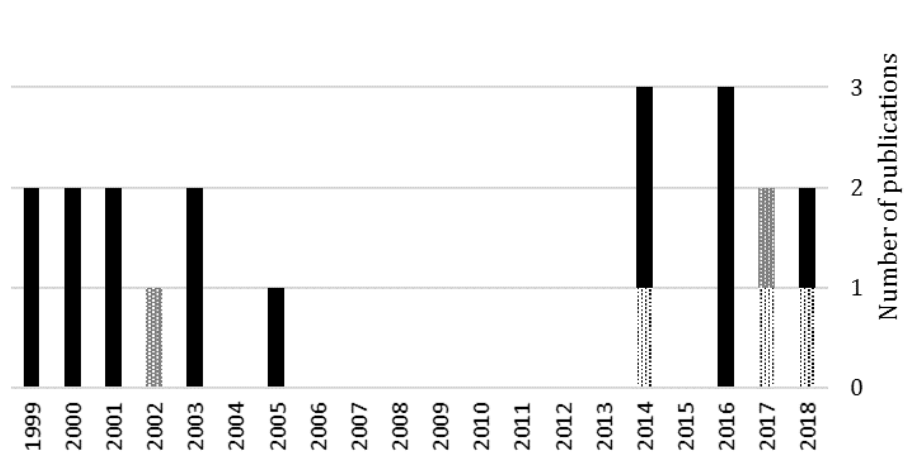
Figure 5. The number of published articles per year and by type of study in the area of non-energy benefits in industry.